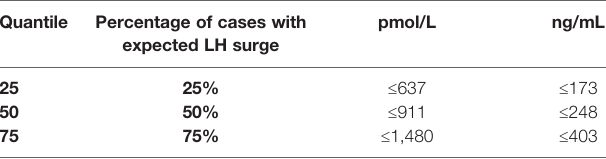
Percentage of cases with the given E2 (pmol/L and ng/mL) concentration at which beginning of LH surge (LH 10- <20 U/L) can be expected to